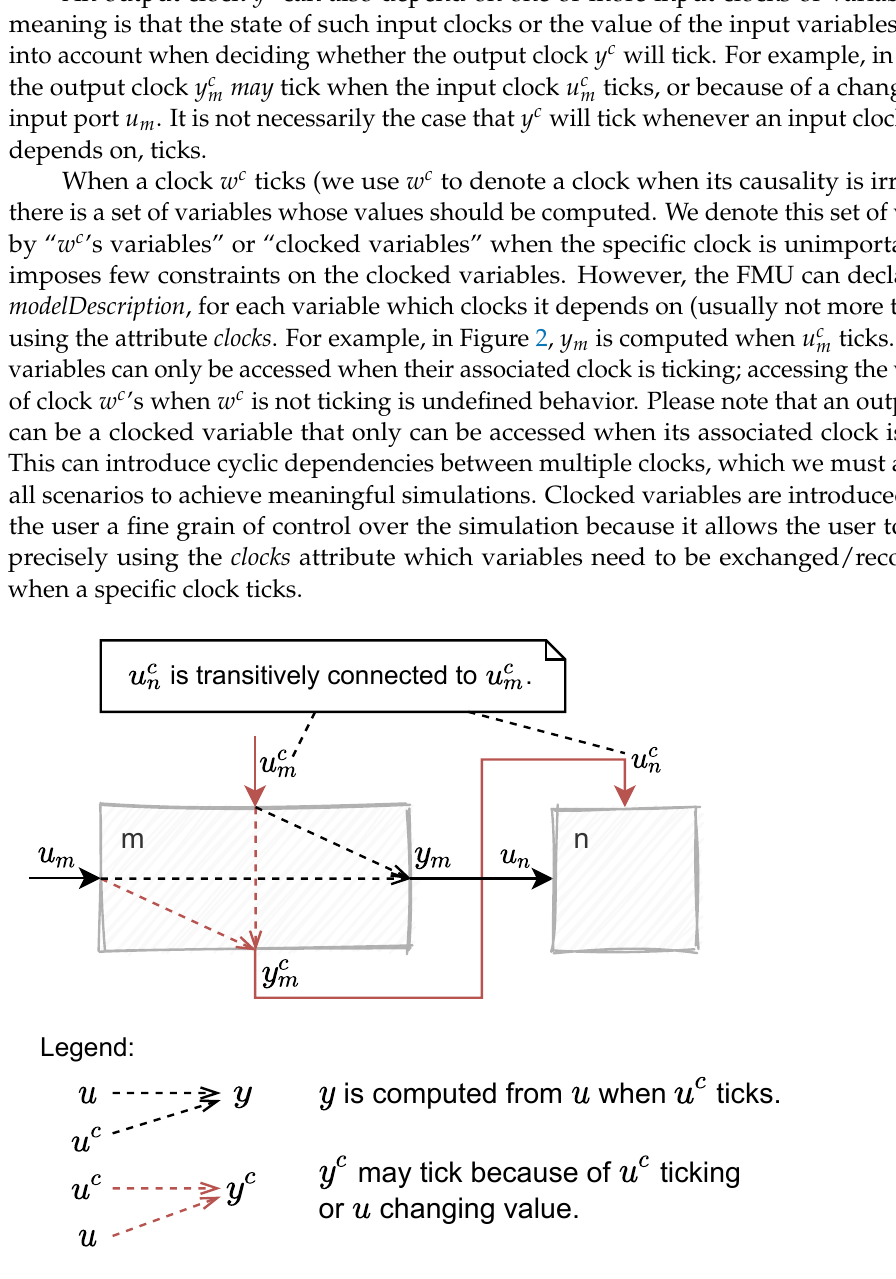
Figure 2. Example clock connections and dependencies. The symbols m and n refer to